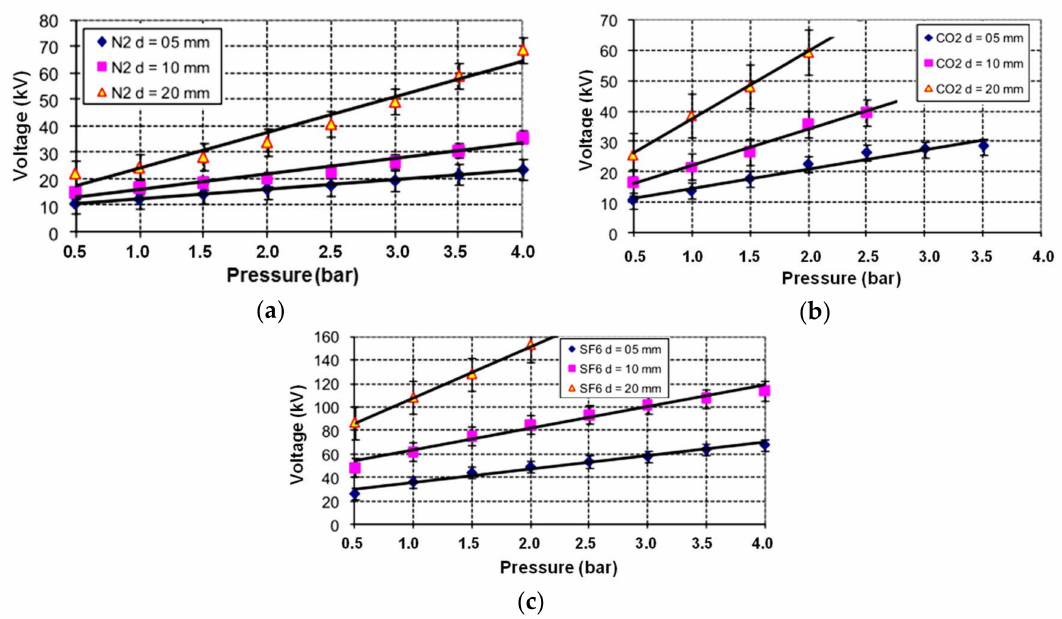
Figure 5. Positive DC breakdown voltage of N 2 ( a ), CO 2 ( b ) and SF 6 ( c ) gases in the point–plane electrode